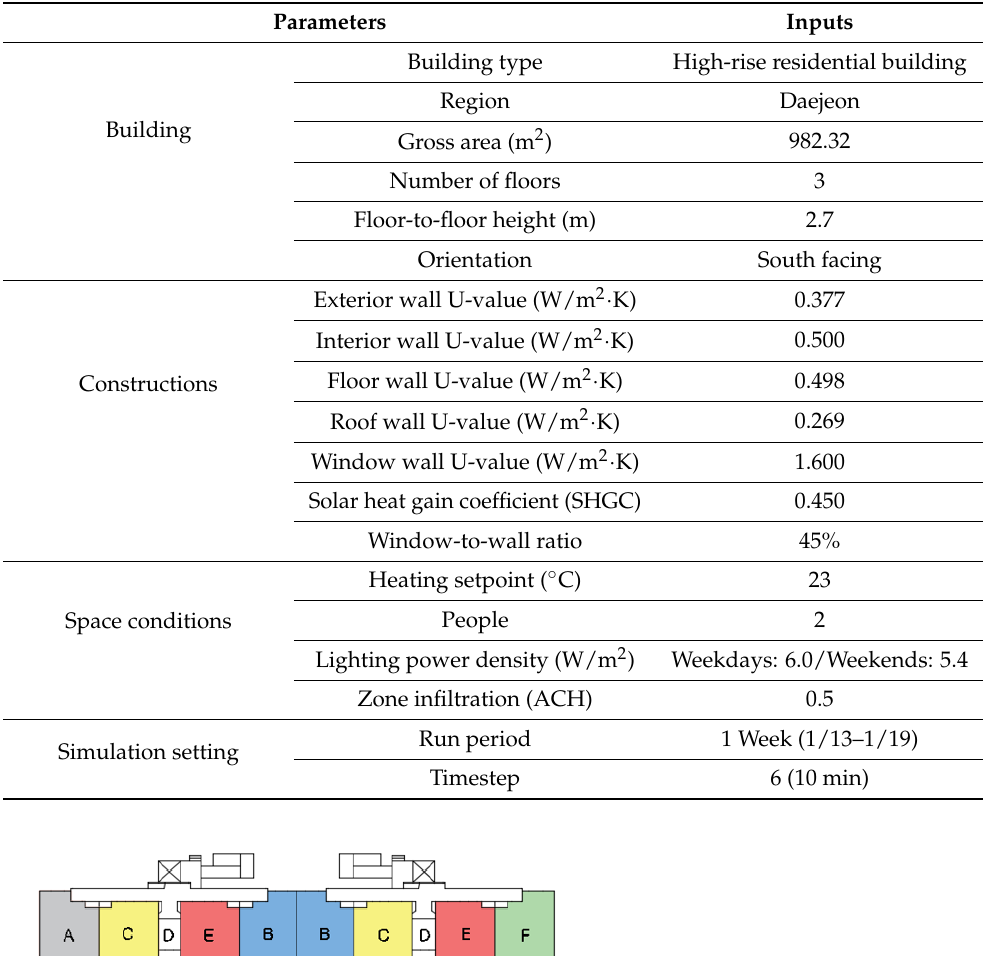
Table 3. Simulation model conditions.